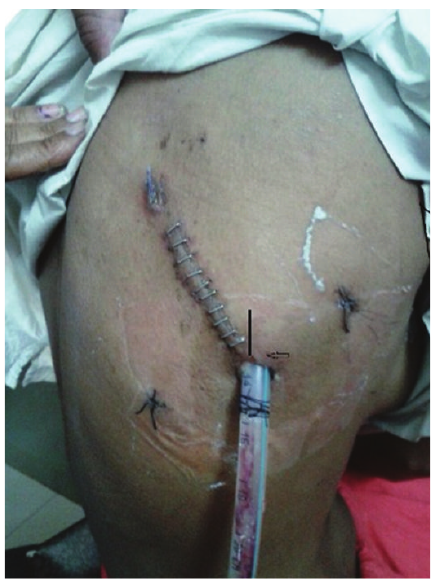
Figure 7: Postoperative photograph of patient showing wound and port sites. Camera port site was at lateral end of main